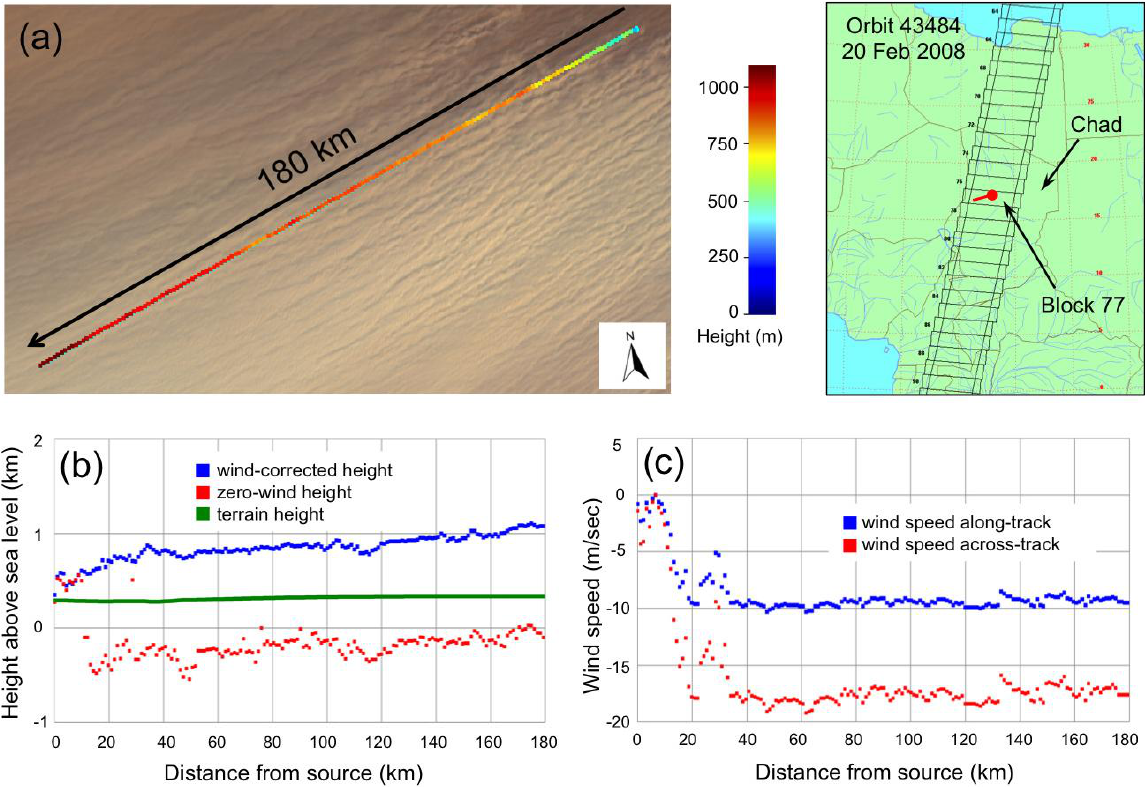
Figure 12. Stereo retrieval results along a digitized line for a large dust plume moving toward the lower left (SW) in the Bodele Depression, Chad on orbit 43484, block 77: ( a ) Nadir RGB image of a portion of plume with color-coded, wind-corrected heights along digitized wind-direction line; ( b ) profile of zero-wind and wind-corrected heights showing zero-wind heights below terrain level and wind-corrected heights at realistic heights; ( c ) profile of across-track and along-track wind